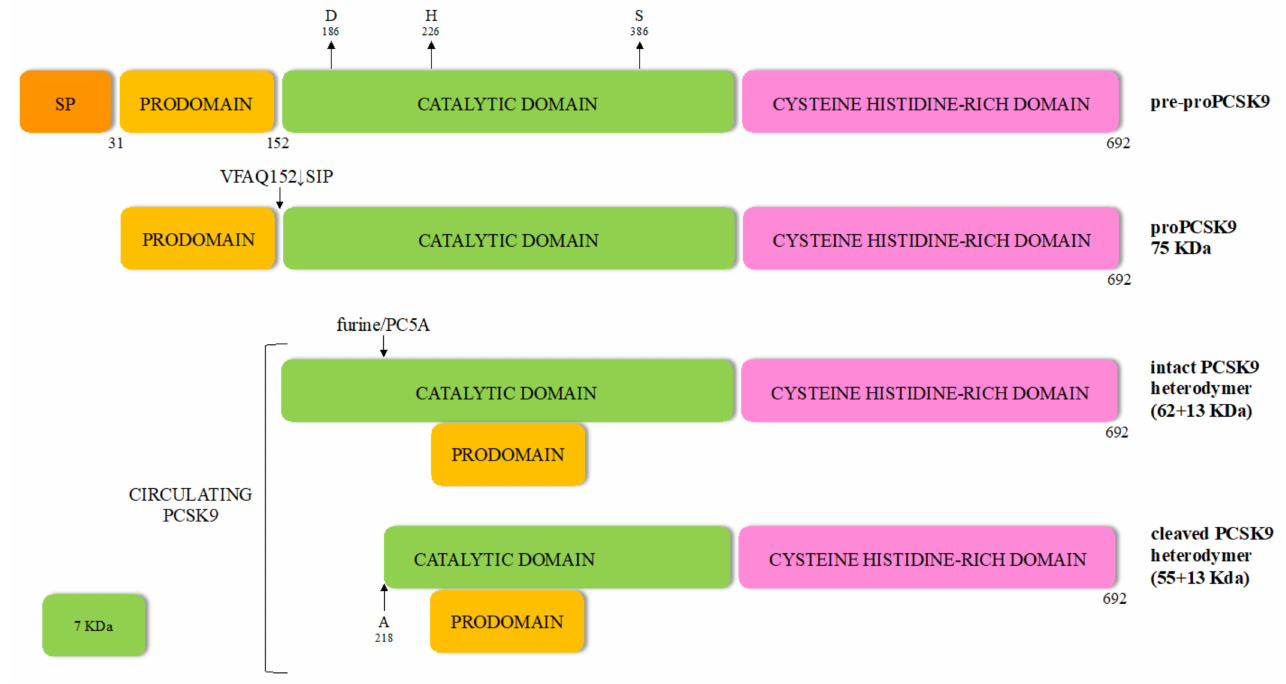
Figure 1. Processing of the zymogen pre-proPCSK9 leading to the cleaved PCSK9 mature form. SP: signal